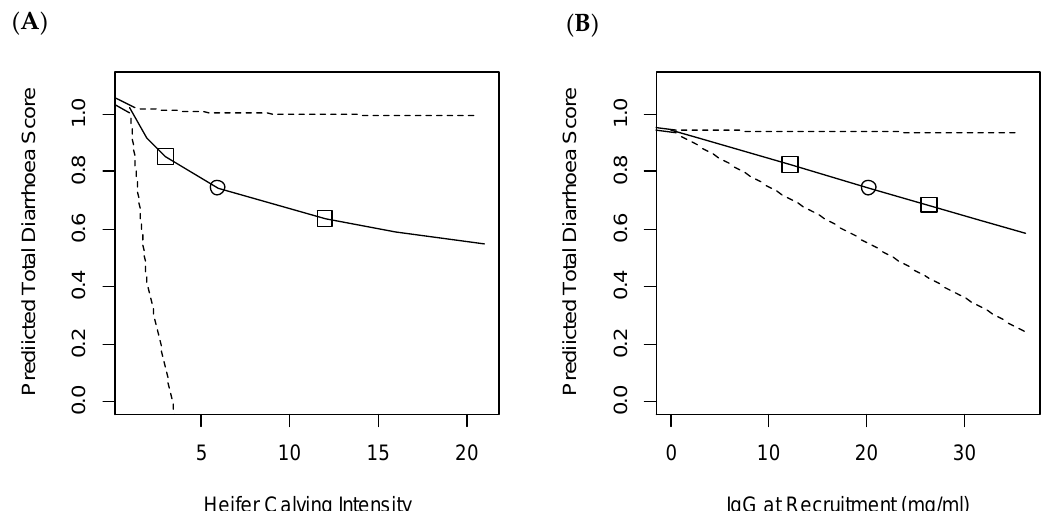
Figure 2. Predicted composite diarrhoea score above the threshold for diagnosis in the first nine weeks based on variation in ( A ) heifer calving intensity (number of heifers born in the same week on the same farm as each individual) and ( B ) serum immunoglobulin (IgG) at recruitment (mg/mL). The study included 492 heifers recruited from 11 farms. The predicted score was calculated using the generalised mixed model output described in Table 2. For each figure median values of the other variables was assumed, which were: IgG at recruitment, 20.2 mg/mL; calving intensity, six heifers born in the same week. Effect estimates were then calculated based on varying only the variable of interest from the first to the 99th percentile. Dashed lines show 95% confidence intervals, ○ indicates the median value and □ the 25th and 75th centiles.